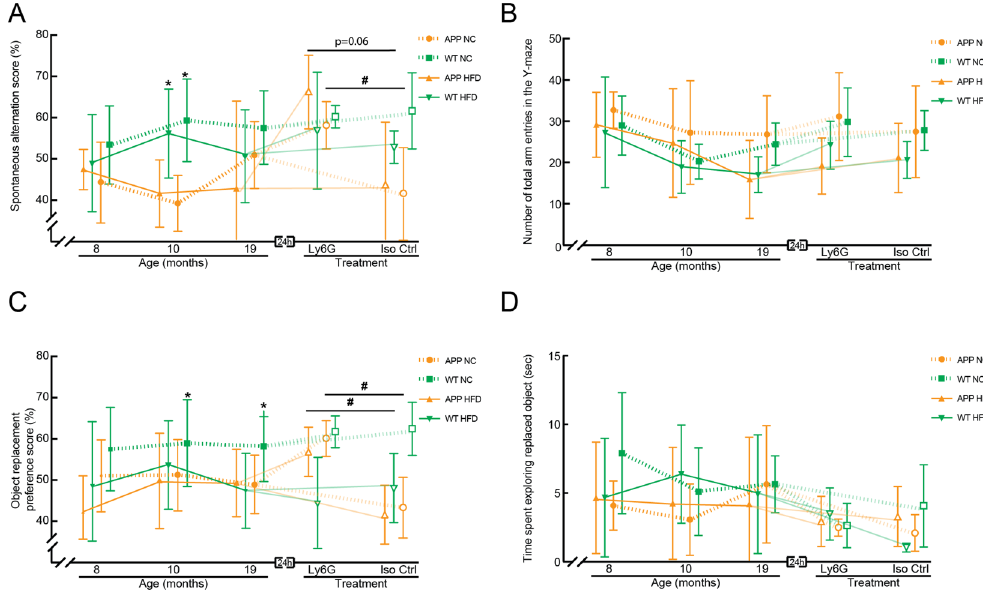
Figure 3. Behavioral assays for short-term memory in APP/PS1 and WT mice on a Hfd or normal chow as a function of age and after treatment with α -Ly6G or Iso-Ctr antibodies. ( A ) Groupwise averages of spontaneous alternation score and ( B ) number of arm entries in the Y-maze taken at baseline for mice at 8, 10, and 19 months of age, and taken 24 hrs after α -Ly6G or Iso-Ctr antibody administration at the 19 month time point (4 mg/kg animal weight, intraperitoneal). ( C ) Groupwise averages of object replacement preference score and ( B ) time spent at the replaced object in the object replacement task taken at baseline for mice at 8, 10, and 19 months of age, and taken 24 hrs after α -Ly6G or Iso-Ctr antibody administration at the 19 month time point (4 mg/ kg animal weight, intraperitoneal). Animal numbers for all measurements — 8 and 10 months: APP/PS1-NC: n = 6; WT-NC: n = 9; APP/PS1-Hfd: n = 10; WT-Hfd: n = 11; 19 months: APP/PS1-NC α -Ly6G: n = 5; APP/ PS1-NC Iso-Ctr n = 4; WT-NC α -Ly6G: 7; WT-NC Iso-Ctr: 6; APP/PS1-Hfd α -Ly6G: n = 5; APP/PS1-Hfd Iso- Ctr: n = 5; WT-Hfd α -Ly6G: n = 4; WT-Hfd Iso-Ctr: n = 5. * p < 0.05 between genotypes (APP/PS1 vs. WT); # p < 0.05 between treatment groups (Ly6G vs. Iso-Ctr); Kruskal-Wallis one-way ANOVA with post-hoc pair- wise comparisons using Dunn’s multiple comparison